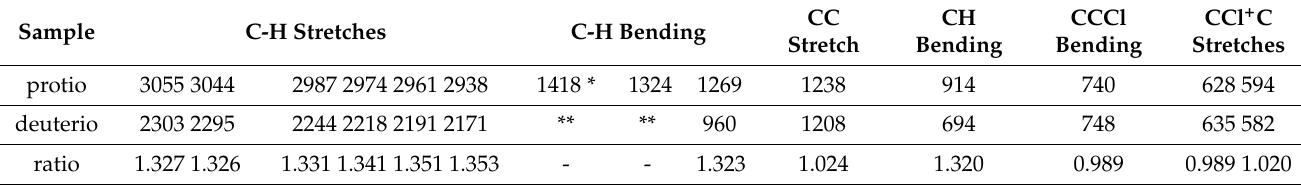
Figure 5. IR spectra in transmittance of the (C 2 H 3 ‐ Cl + ‐ C 2 H 3 ) {Cl 11 − } salt (red) and its deuterated analog (blue). Asterisks indicate bands of the {Cl 11 − } anion (two bands of CH stretching of the anion of variable intensity are observed due to the partial involvement of the CH group in H bonding). For a better examination of the bands of CH stretching vibrations, the difference between the protio and deutero spectra is shown (dashed black curve). The intensities of both spectra are reduced to unit anion intensity. Table 2. Comparison of the IR spectra of cations C 4 H 6 Cl + and C 4 D 6 Cl + in their salts with the {Cl 11 − } anion.